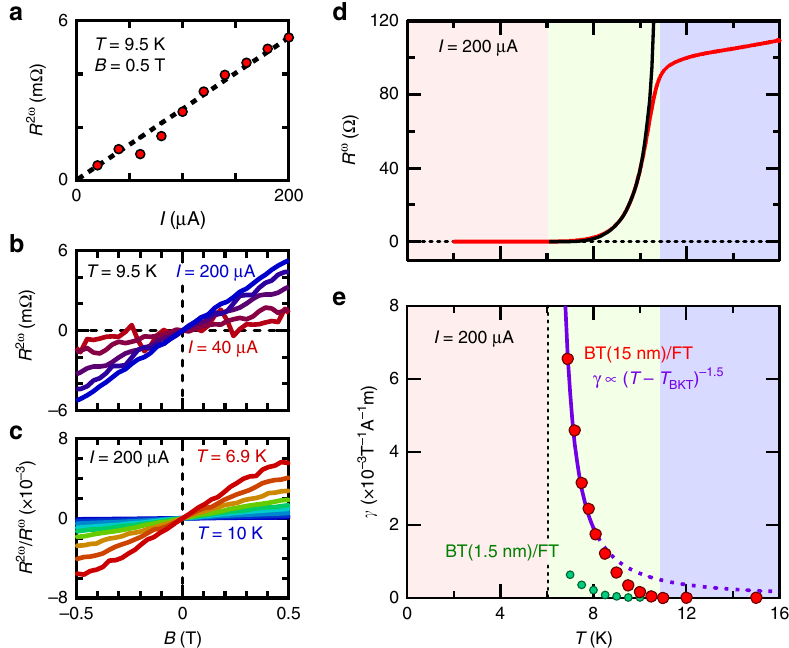
Fig. 2 Current-magnitude and temperature dependence of nonreciprocal transport. a The current-magnitude dependence of second harmonic resistance R 2 ω at T = 9.5 K, and B = 0.5 K deduced from the data shown in b . The black dotted line is the fi tting line. b The magnetic fi eld dependence of R 2 ω at T = 9.5 K measured under I = 40, 80, 120, 160, and 200 μ A. c The magnetic fi eld dependence of R 2 ω / R ω measured under I = 200 μ A at T = 6.9, 7.2, 7.5, 7.8, 8.1, 8.5, 9, 9.5, and 10 K. d The temperature dependence of resistance measured under I = 200 μ A. The black curve is the fi tting of the